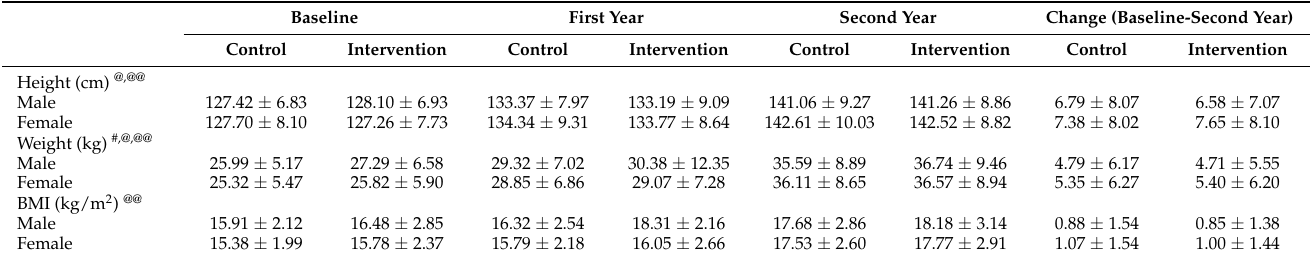
Figure 6. Changes in proportion for children’s overweight and obesity in first and second year from baseline. Multilevel model was used to evaluate the effect of the intervention after adjusting for physical activity. Overweight: group effect: p < 0.05; time effect (two years): p < 0.05. Obesity: group effect, p < 0.05. Others all p > 0.05. Table 9. Comparison of height, weight, and BMI of children between intervention group and control